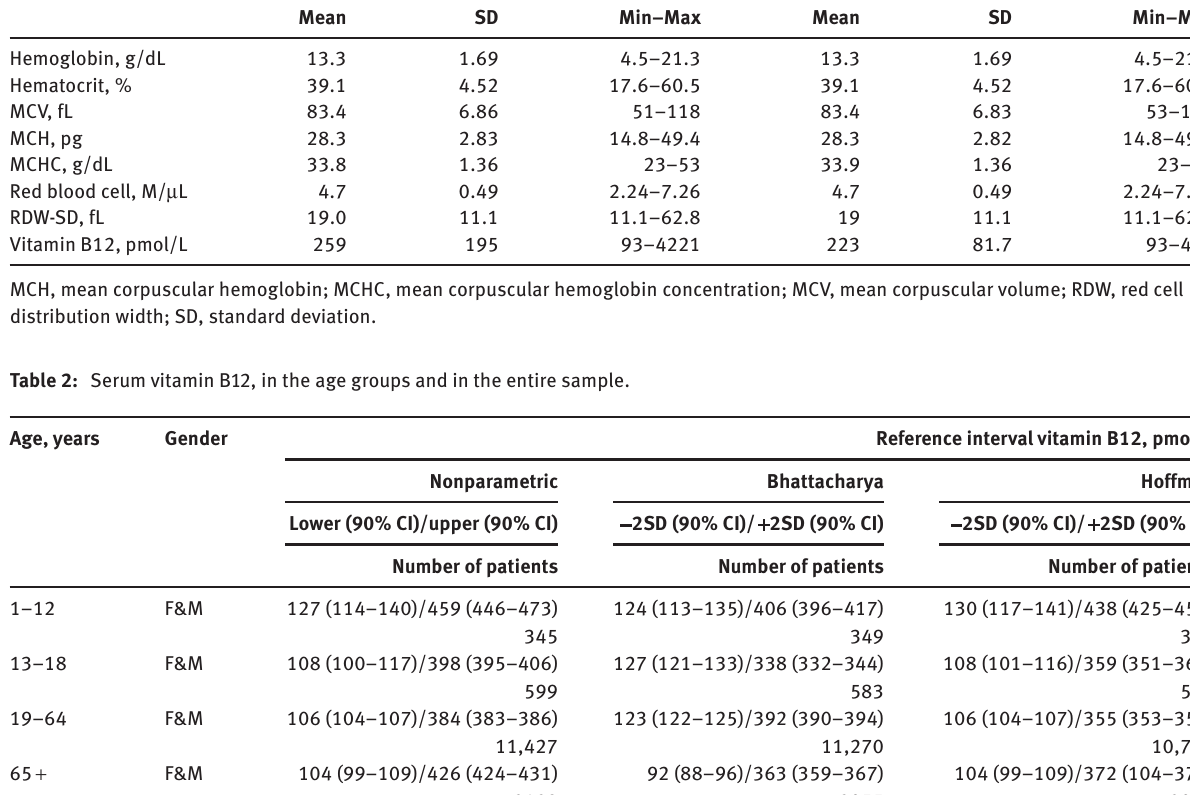
Hemoglobin, g/dL